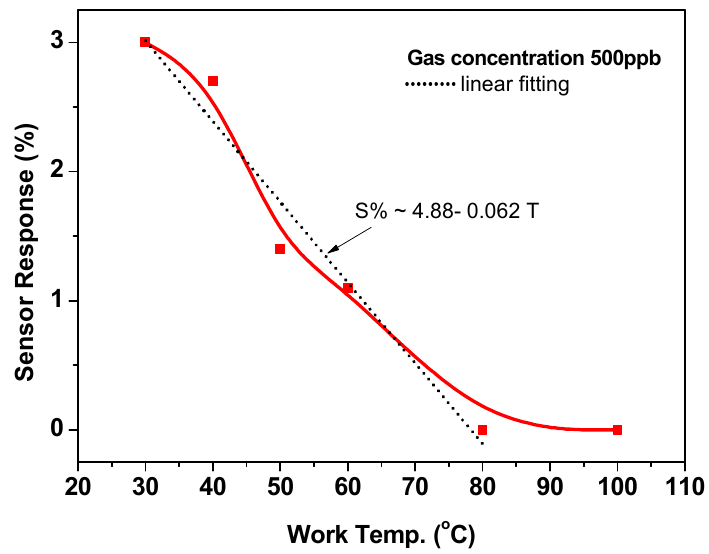
Figure 6. The sensor response toward 500-ppb ethylene gas at various working temperatures.